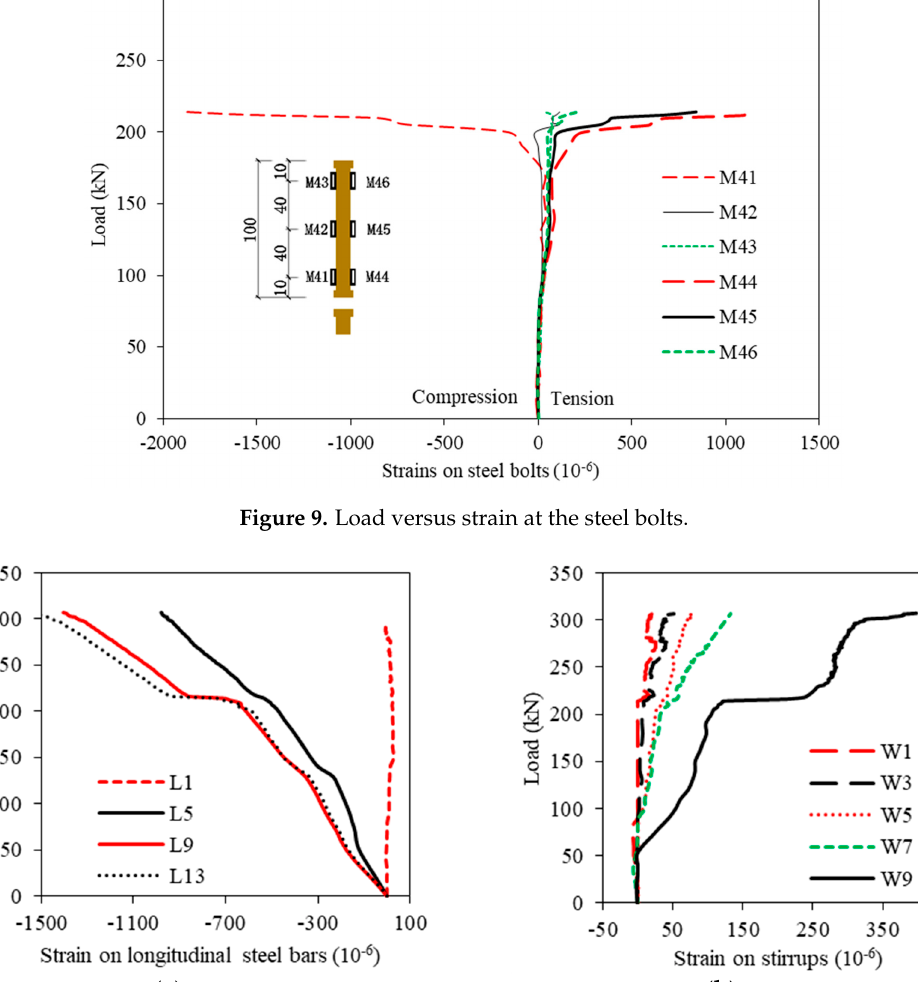
Figure 10. Load versus the strain of ( a ) the longitudinal bars, and ( b ) the stirrups.